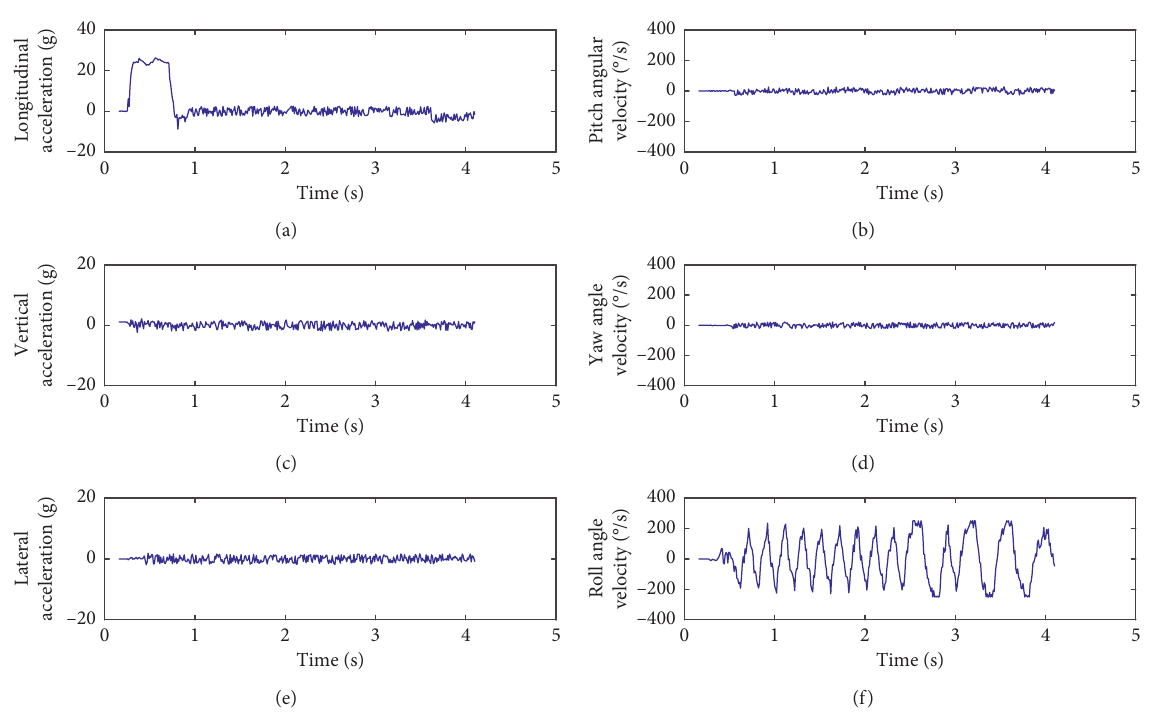
Figure 17: Raw data from the autonomous flight